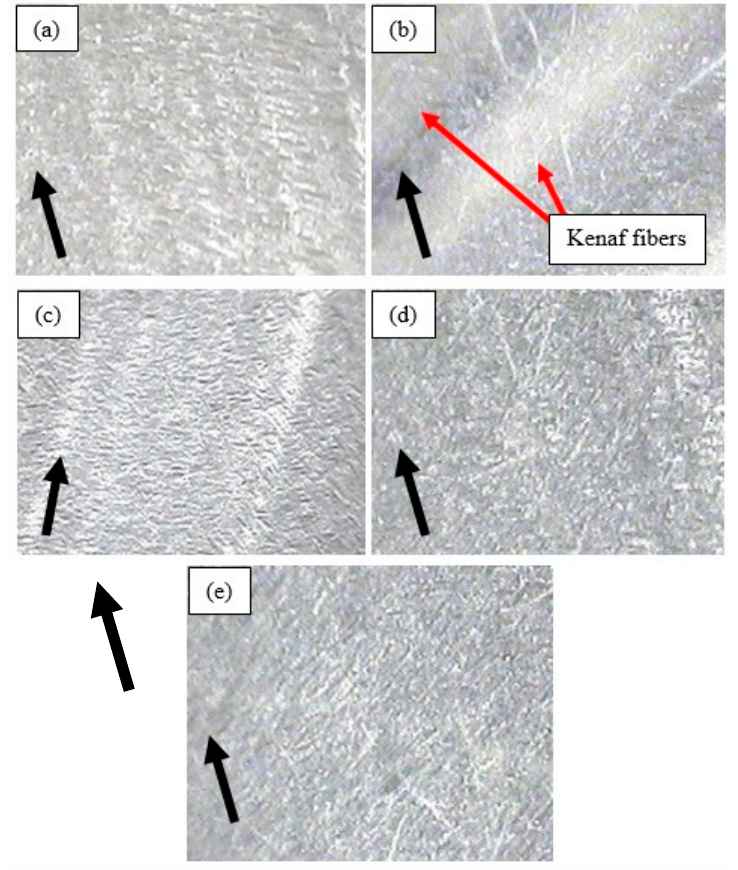
Figure 8. Images of the abraded surfaces for: ( a ) Epoxy, ( b ) epoxy–kenaf, ( c ) 0.5 wt.% PMWCNT–epoxy–kenaf, ( d ) 0.75 wt.% PMWCNT–epoxy–kenaf, and ( e ) 1 wt.% PMWCNT–epoxy–kenaf composites (magnification of 10x).